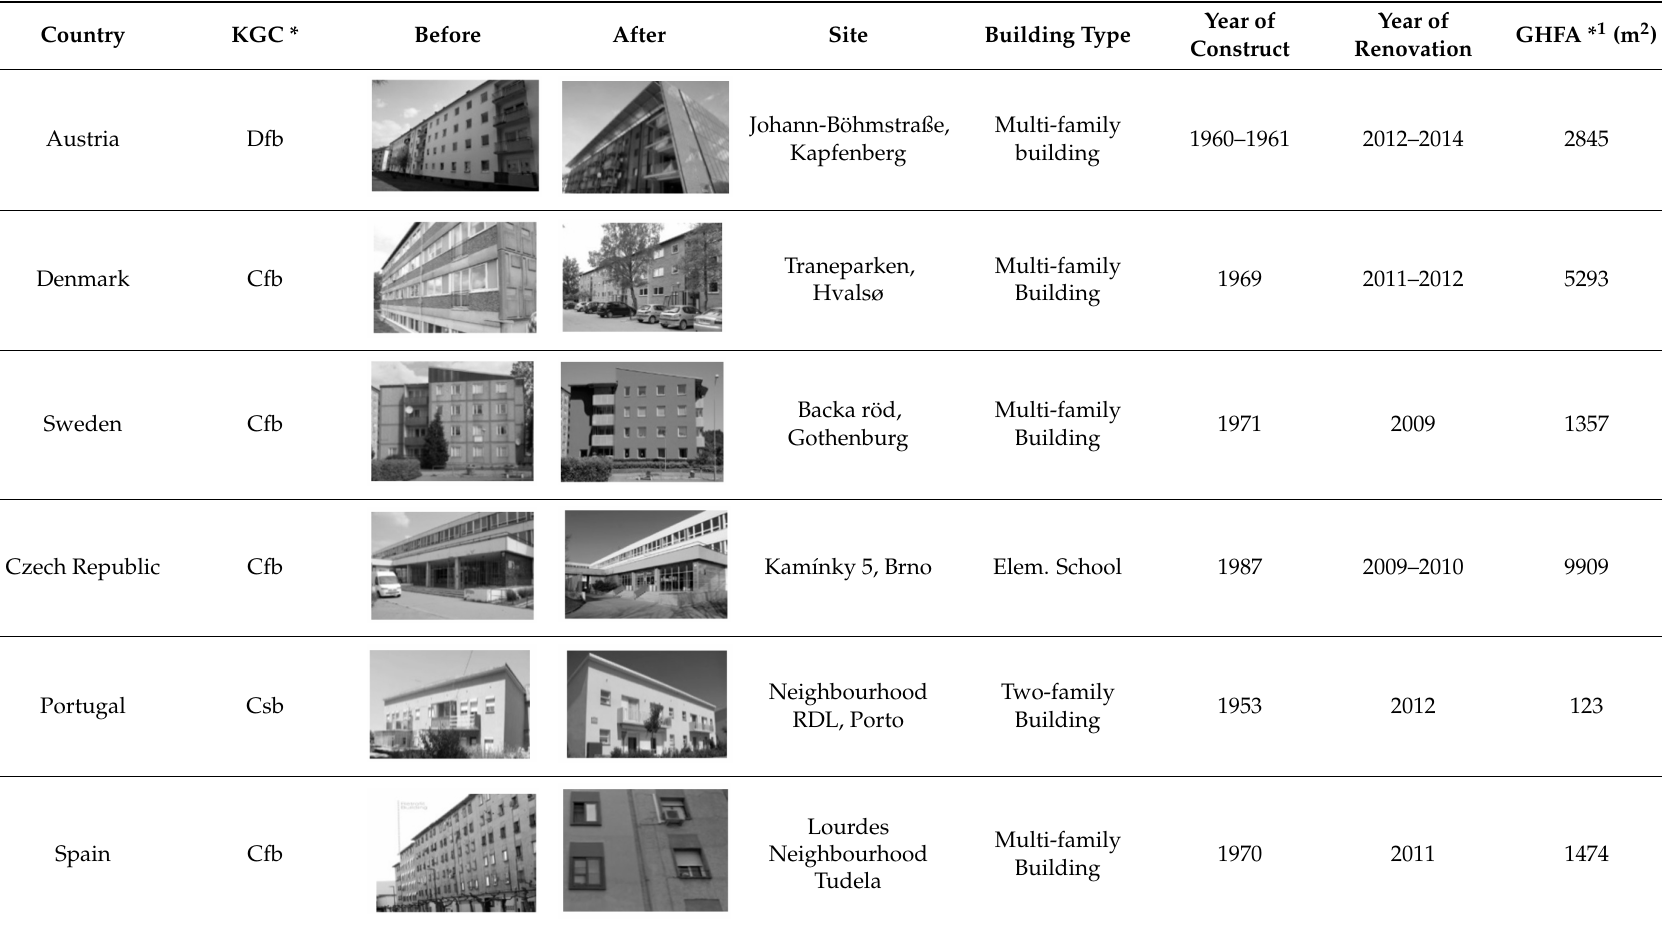
Table 2. Overview of the case studies: Adapted from